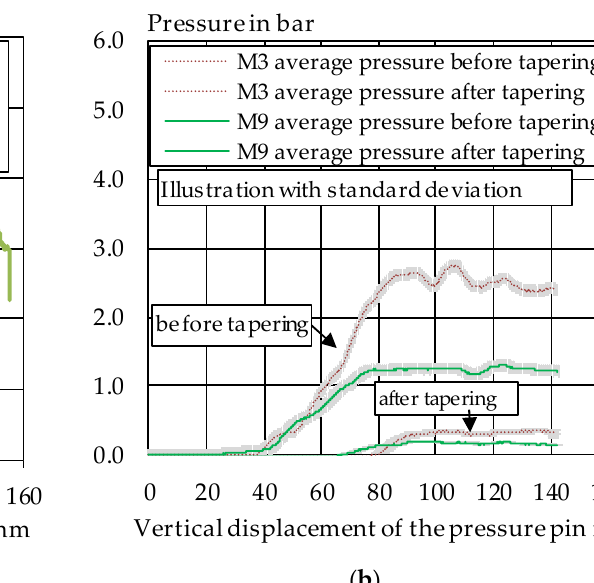
12 Figure 10. Measured pressure during the test immediately before tapering in the capillary rheome- ter for all mixtures. Non-extrudable mixtures are shown as dotted lines.